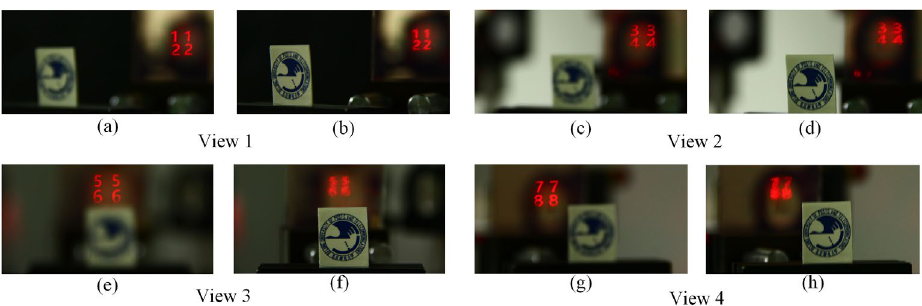
Figure 8. The AR effect of view 1 ( a ) the camera focused on the figures ( b ) the camera focused on the school badge. The AR effect of view 2 ( c ) the camera focused on the figures ( d ) the camera focused on the school badge. The AR effect of view 3 ( e ) the camera focused on the figures ( f ) the camera focused on the school badge. The AR effect of view 4 ( g ) the camera focused on the figures ( h ) the camera focused on the school badge.